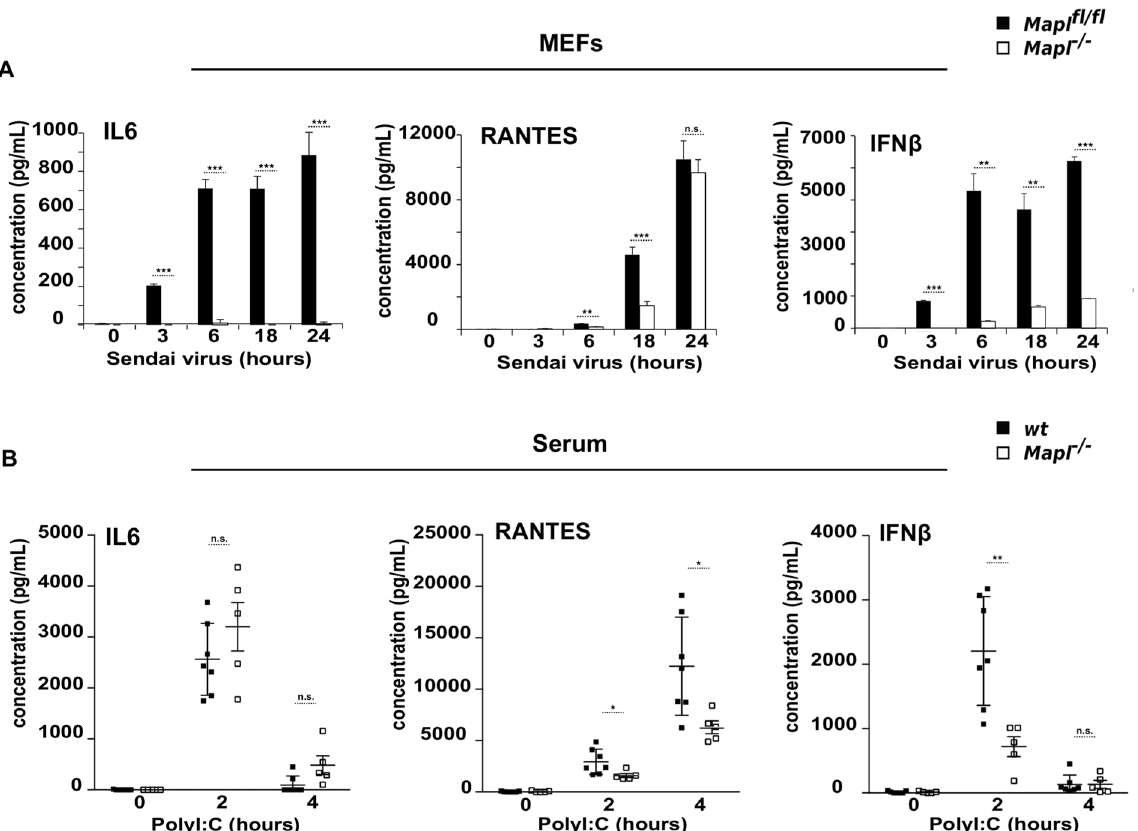
Figure 1. Defective innate immune response in vitro and in vivo in the absence of MAPL. ( A ) Mapl fl/fl and Mapl − / − MEFs were left untreated or infected with Sendai virus (150 HAU/mL) over a time course of 24 hours. IL6, RANTES and IFN β were measured in supernatants by ELISA. (n = 3). ( B ) Wild-type (WT) (n = 7) and Mapl − / − (n = 5) mice were injected intravenously with saline or PolyI:C for 2 hrs and 4 hrs. Serum IL6, RANTES and IFN β were measured by ELISA. Results are expressed as the median induction, comparing Mapl − / − to Mapl fl/fl or WT. * P < 0.05, ** P < 0.01 and *** P < 0.001, n.s.,